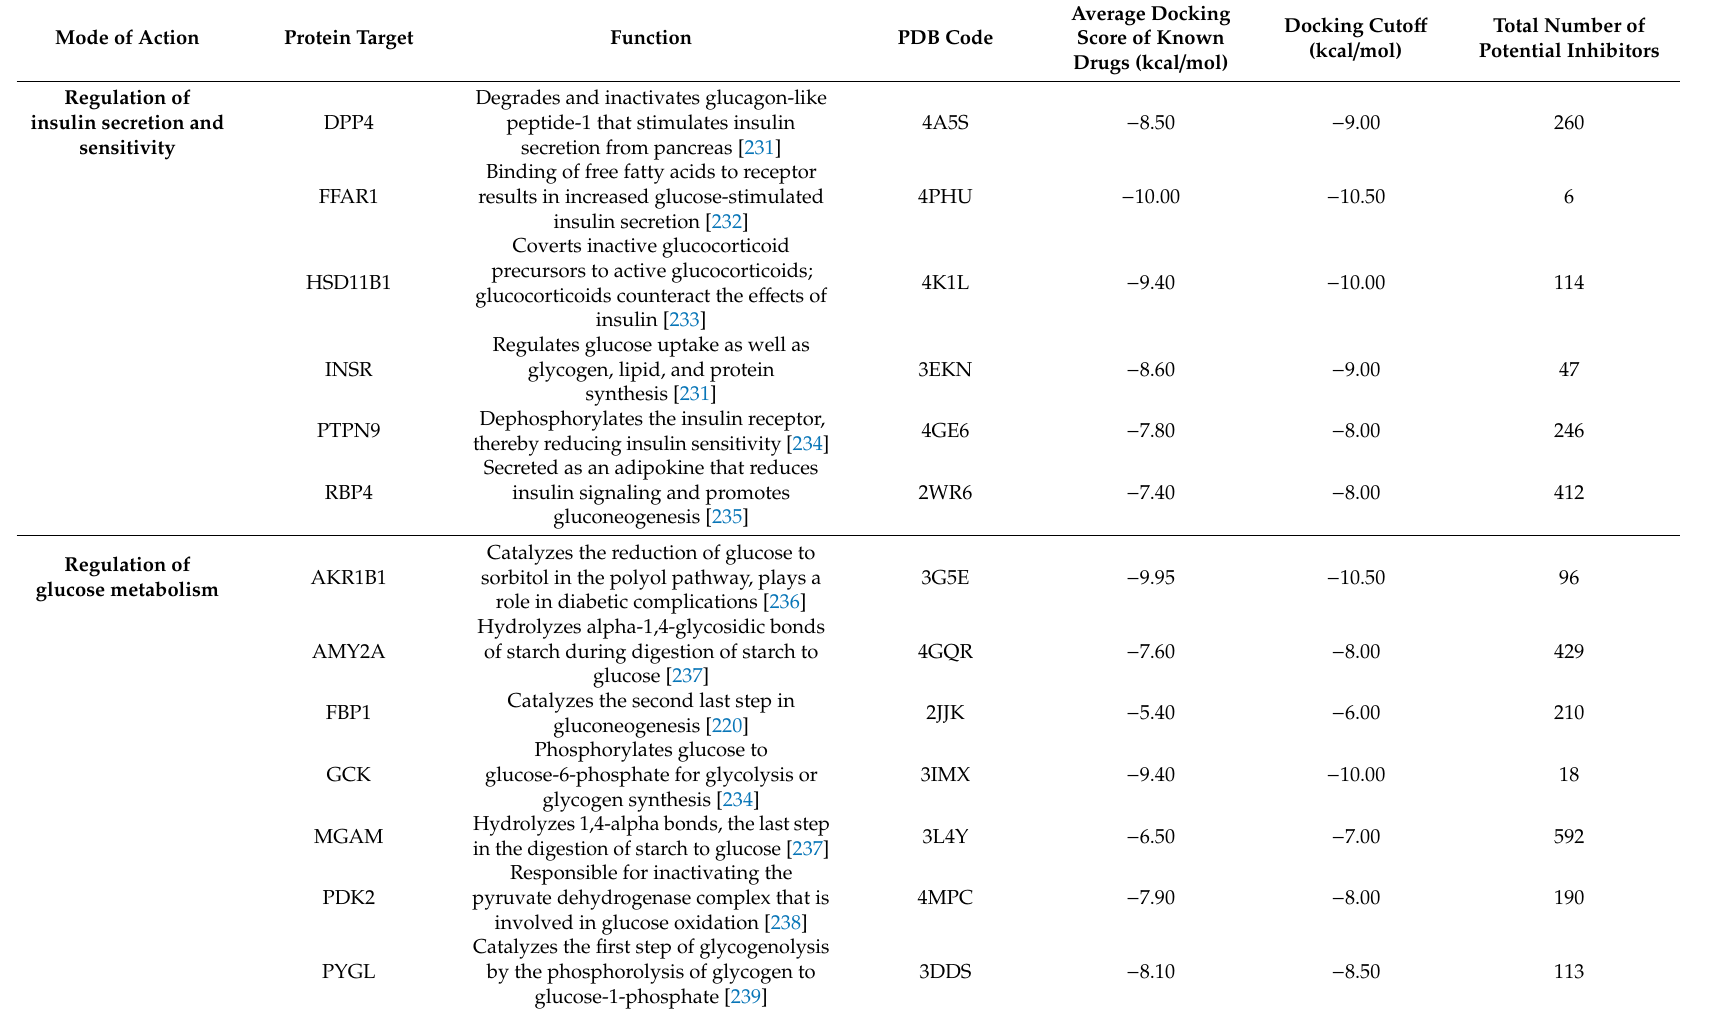
Table 3. The major biological functions of the DIA-DB protein targets, the docking cuto ff score, and the total number of potential inhibitors identified for each target. Mode of